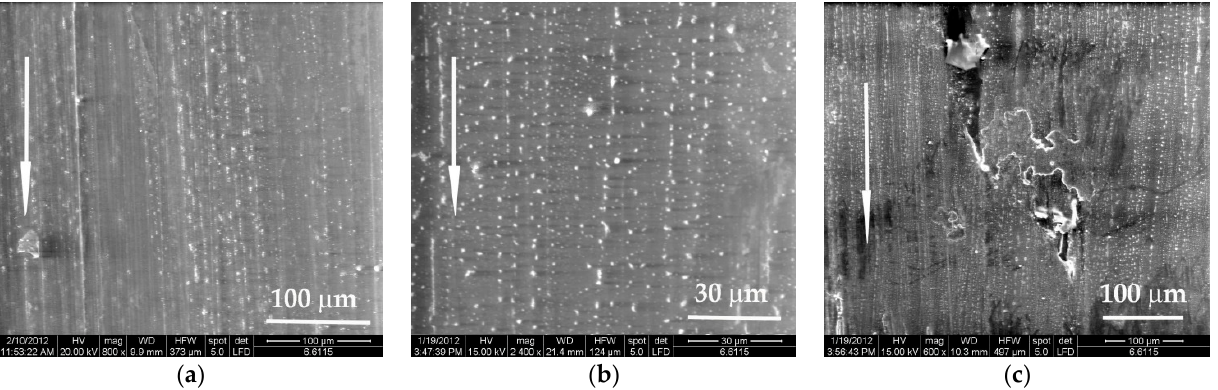
Figure 13. Aspects of worn surfaces for blocks made of PBT + 15% PTFE, tested under 5 N, for a sliding distance of L = 7500 m: ( a ) v = 0.5 m/s; ( b ) v = 0.25 m/s and ( c ) v = 0.25 m/s, worn surface with rolled conglomerate debris and thin debris reattached and pressed on the surface.